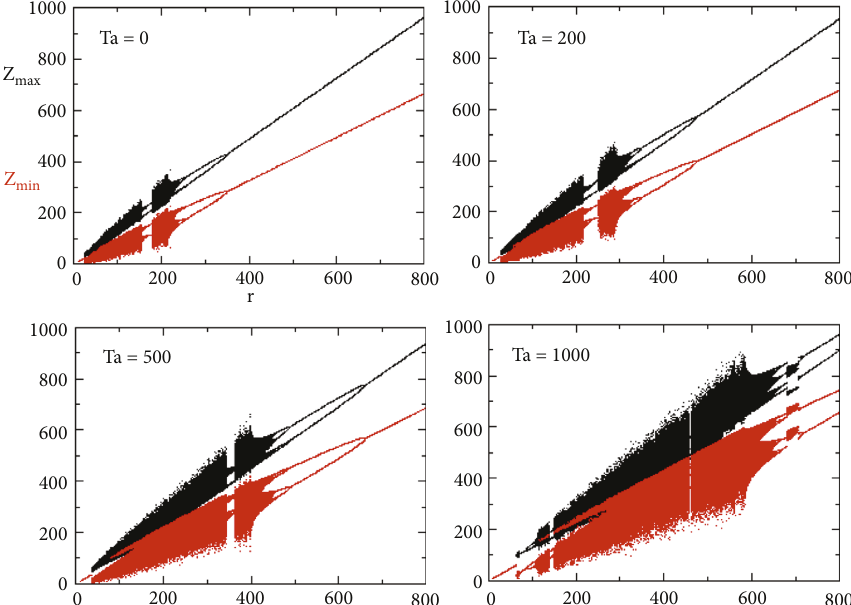
Figure 11: Diagrams of bifurcations of Z as a function of r showing the effect of the Taylor number Ta when Λ � 1, Da � 1, s � 0, P � 10, � √ k � π / � 1 , η � 8/3, ε � 1, and σ � − 1/3 2 , L � M 2